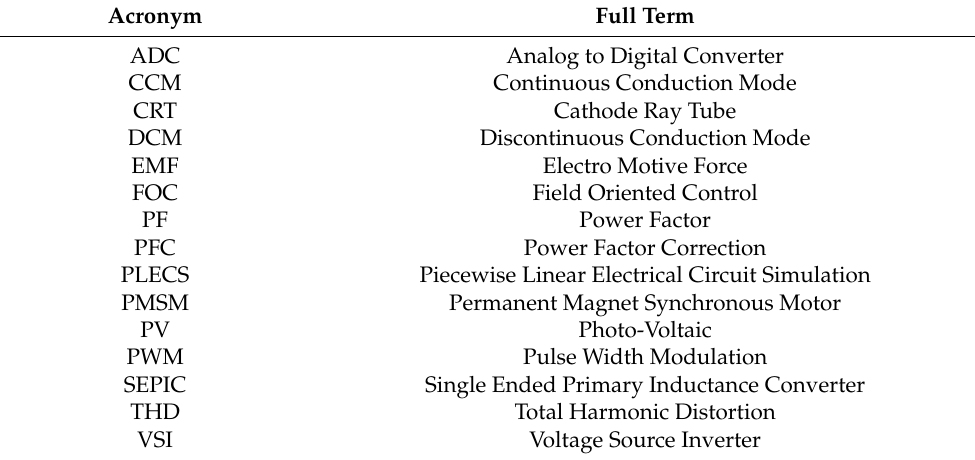
Table A1. List of acronyms.